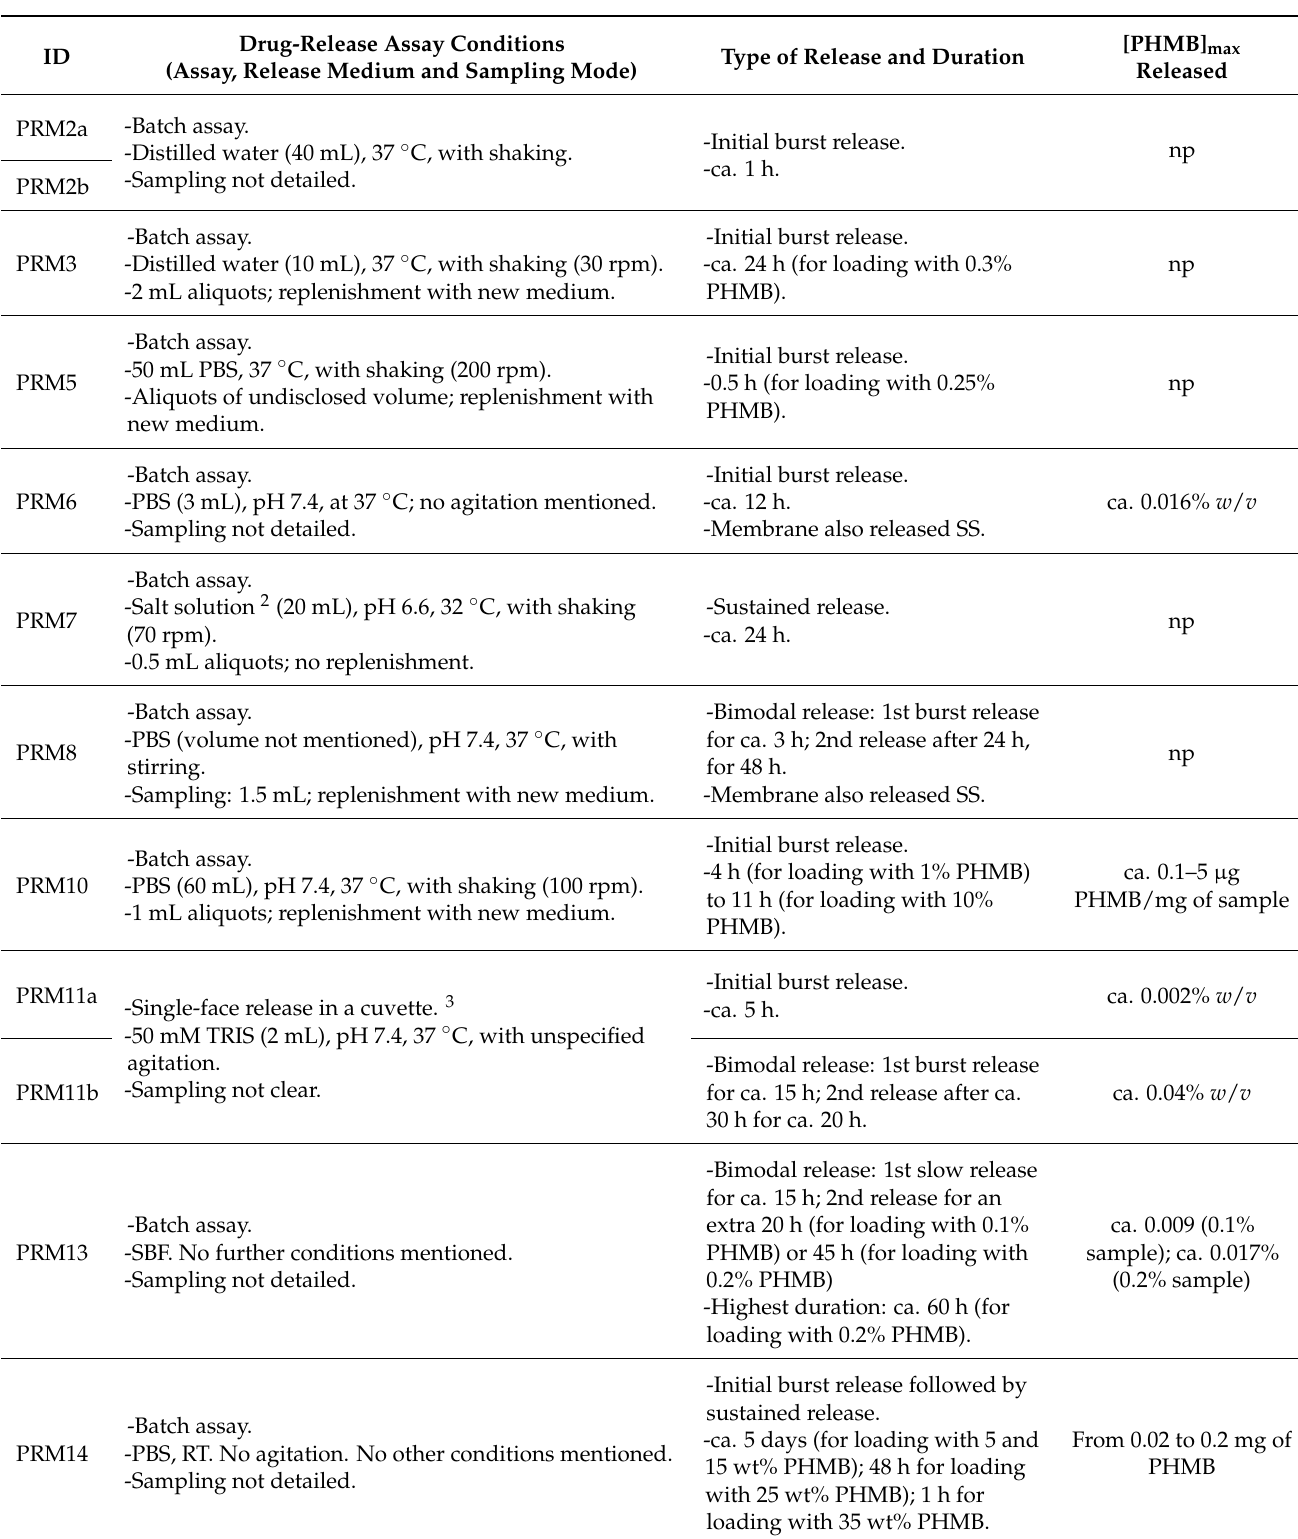
Table 7. Summary of the drug-release studies carried out with PHMB-releasing membranes (PRMs) developed for antimicrobial dressings (AMDs). Membrane IDs and corresponding bibliographic references are the same as in Table 3.